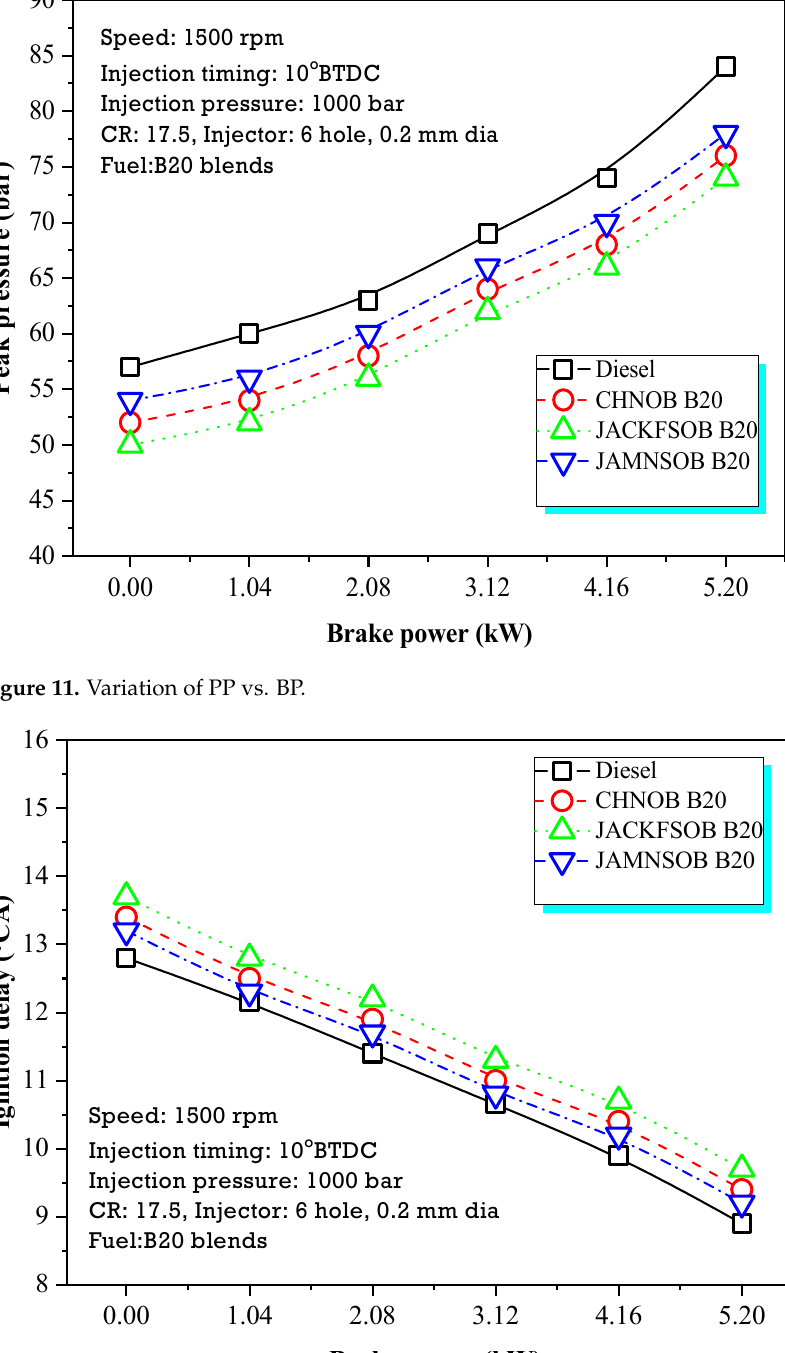
Figure 12. Variation of ID vs. BP.